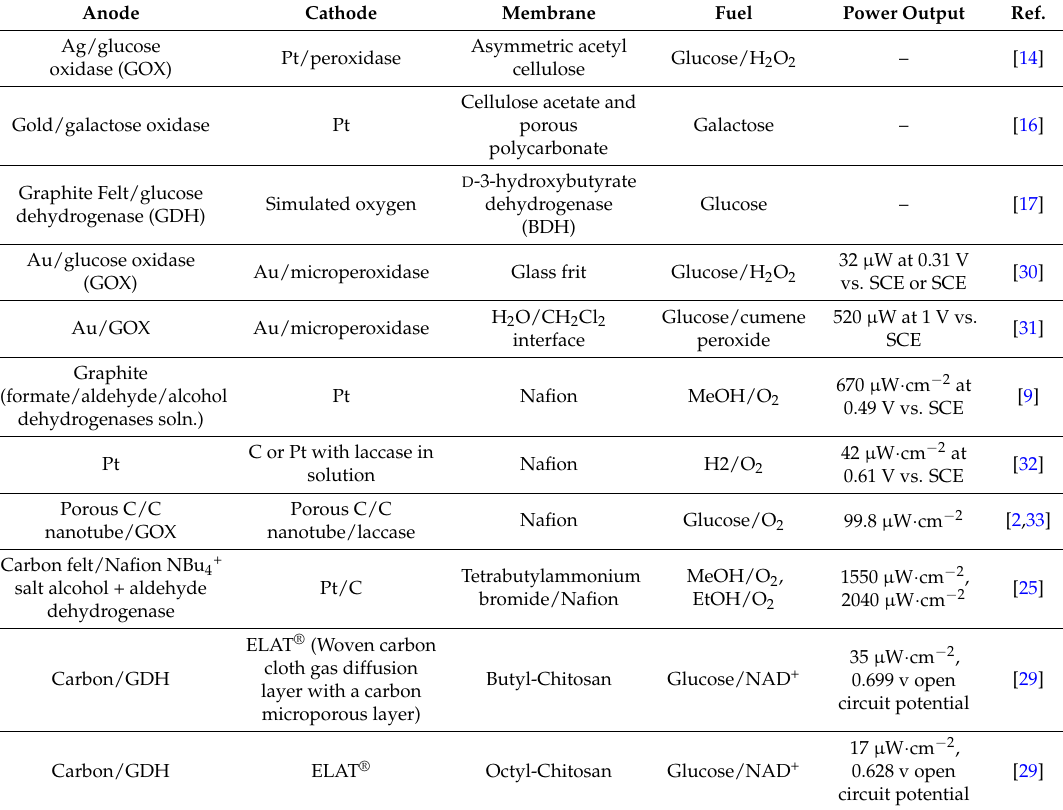
Table 1. Summary of the performance of enzymatic biofuel cells employing semi-permeable